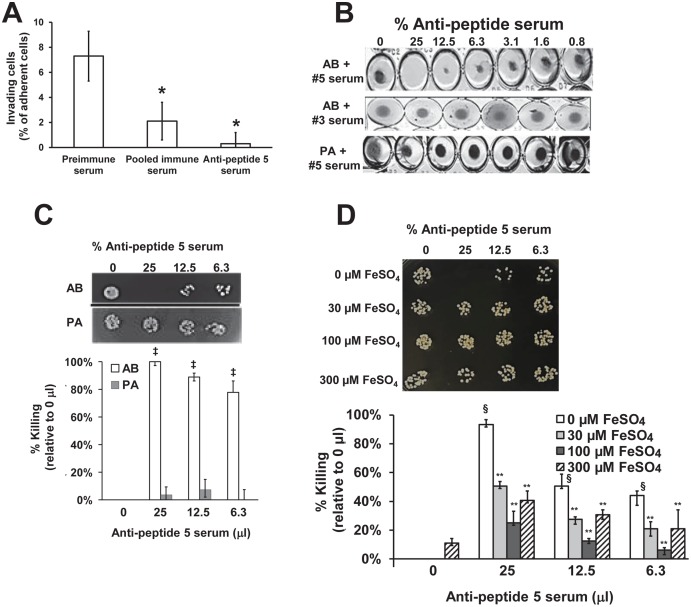
Invasion of alveolar epithelial cells by XDR A. baumannii in the presence of rabbit serum collected before or after immunization (10 μg) with Hyr1p peptides.Data (n = 6) expressed as % invading cells (mean + SD) of the adherent cells enumerated after lysing mammalian cells without colistin treatment (A). *P<0.01 vs. preimmune serum. Effect of anti-peptide 5 serum on the viability of A. baumannii (AB) or P. aeruginosa (PA) in vitro (B). Bacterial cells (1 x 105 cells) in MHII medium were incubated in 96-well plate at 37°C for 20 h with varying concentrations of the immune serum. Killing activity of anti-peptide 5 serum was enumerated by CFU (n = 3 per arm) expressed as % killing relative to cells without any anti-peptide 5 serum. ‡P<0.005 vs. no serum (C). Experiments in B were repeated with A. baumannii inoculated in different concentrations of FeSO4 supplemented media (D) and the CFU (n = 6 per arm) were enumerated and expressed as % killing relative to cells without any anti-peptide 5 serum or FeSO4. §P< 0.01 vs. no serum no FeSO4. **P <0.05 vs. no FeSO4 at the corresponding serum concentration.